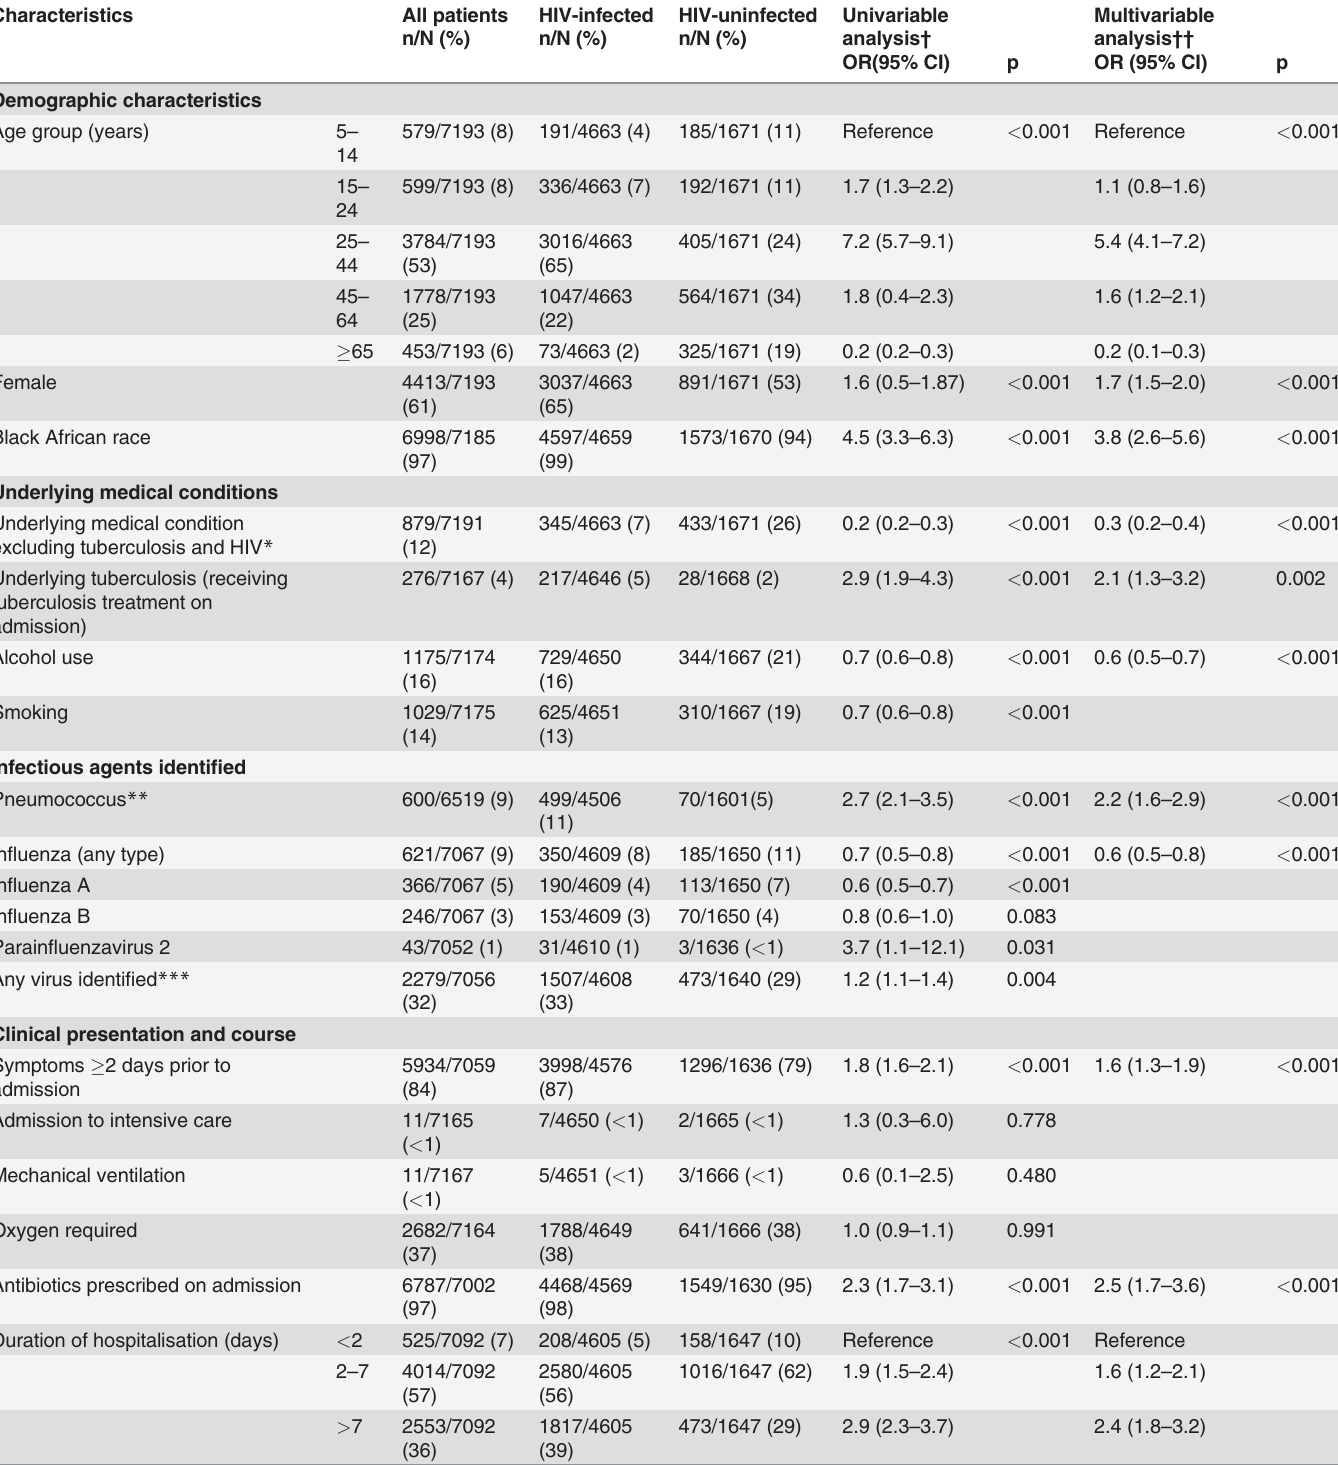
Table 1. Comparison of the clinical and epidemiologic characteristics of HIV-infected and -uninfected individuals aged (cid:1) 5 years hospitalised with severe acute respiratory illness (SARI) at four sentinel surveillance sites, South Africa, 2009 – 2012.